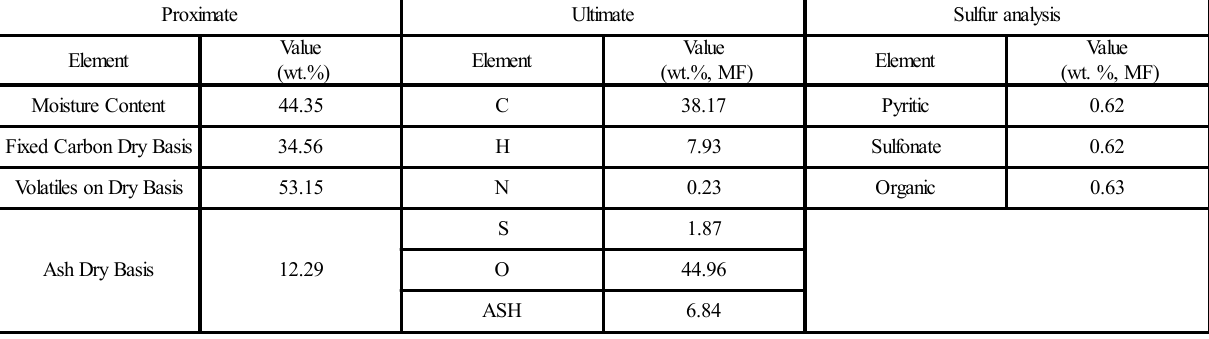
TABLE 5. PROPERTIES OF THAR (AS RECEIVED BASIS) COAL FIELD [18]